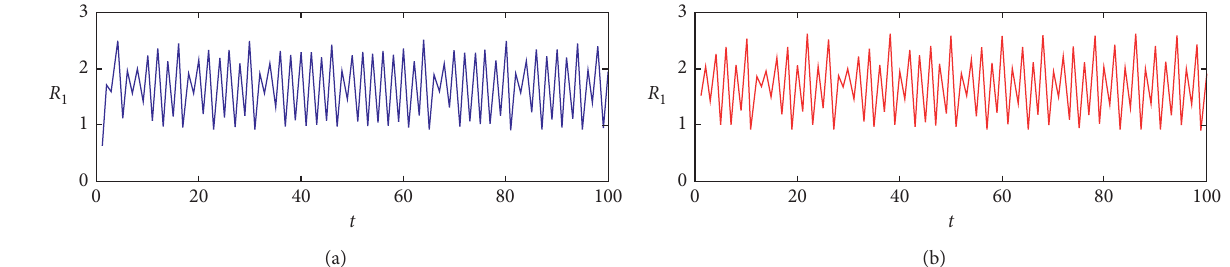
Figure 10: Orbits of R